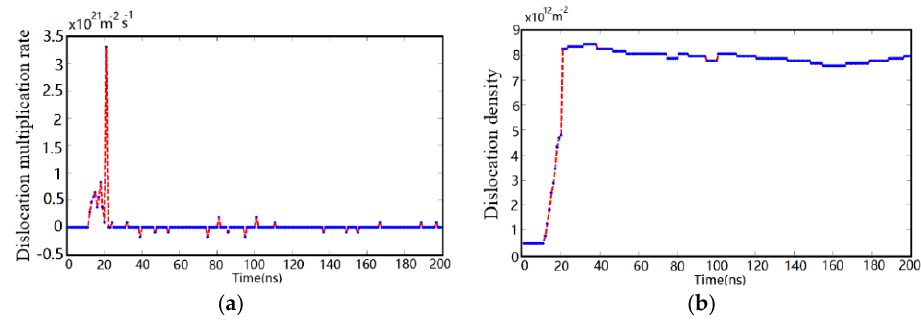
Figure 9. The evolution process of dislocation multiplication rate and total dislocation density during transient irregular cutting process. The red line represents the significant change of variables, and the blue line represents the gradual evolution of variables. ( a ) Dislocation multiplication rate evolution; ( b ) dislocation density evolution.